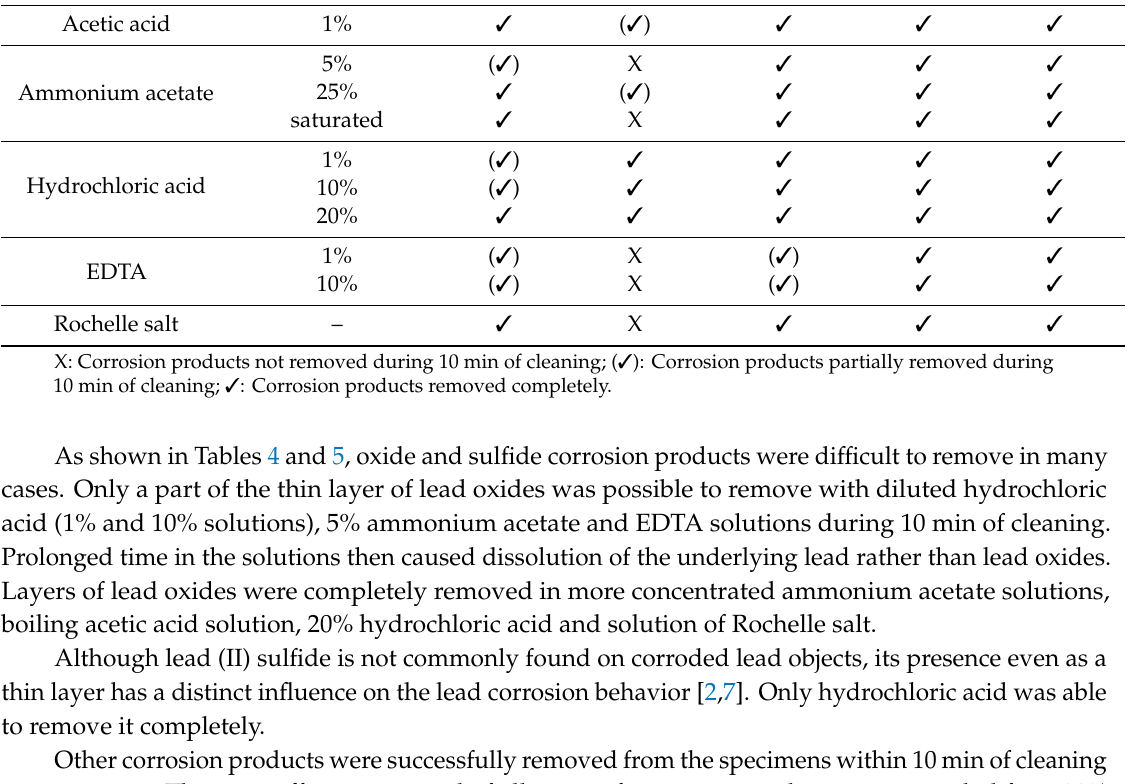
Table 5. E ff ectiveness of cleaning solutions to remove specific corrosion products. Solution